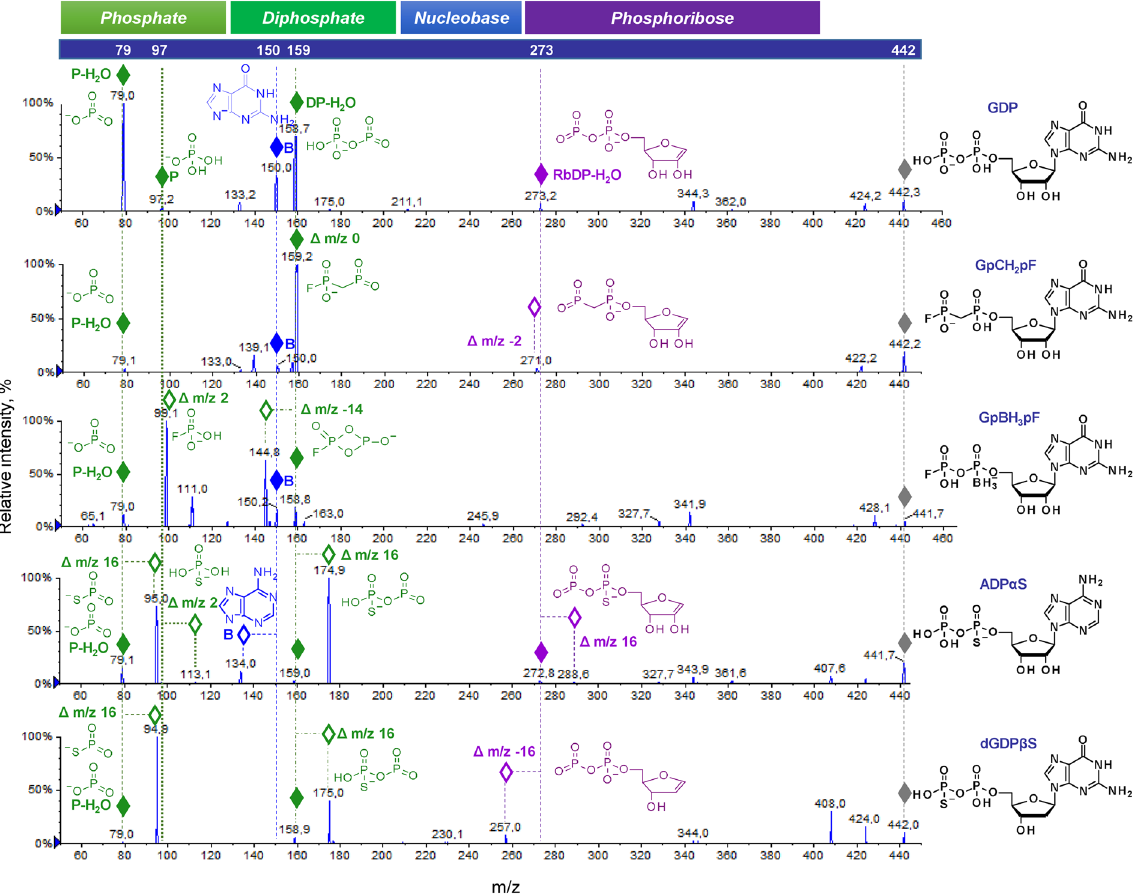
Figure 5. Analysis of phosphate- and ribose-modified nucleotides isobaric with GDP ( m/z 442) by ESI( − )/MS/ MS. In each spectrum, fragmentation ions enabling determination of the modification site(s) (nucleobase versus phosphate versus ribose) are indicated with diamonds ( ◊ ) and their proposed structures are